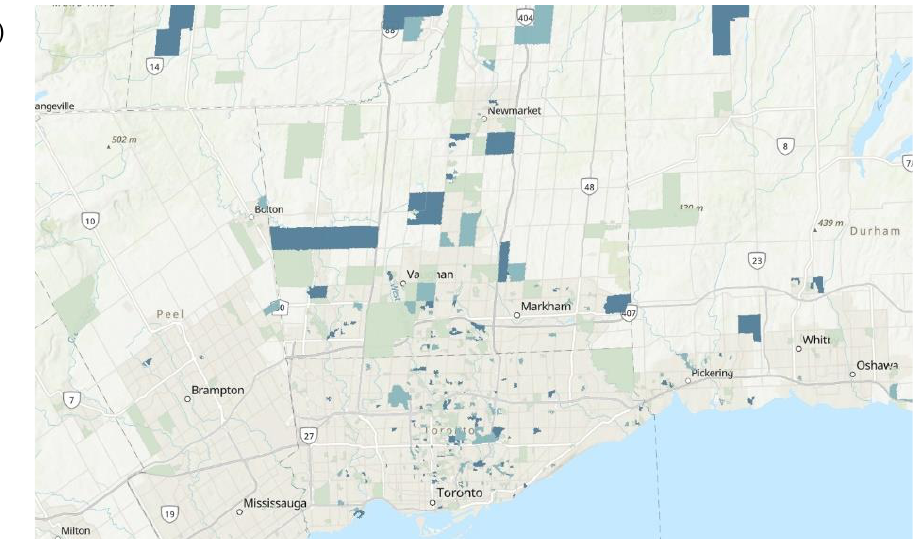
Figure 1. Average Delay Time of Examinations Between the pre-pandemic period (period 1) and during the height of the COVID – 19 pandemic period (period 2) of Examinations Per Dissemination Area. A map of Greater Toronto Area, Ontario, Canada with patients aggregated by dissemination area and average delay time (days) calculated for each dissemination was produced by ArcGIS online. Dissemination areas of patients are marked by a gradient based on delay time. The darkest blue shows a delay in examination >180 days while the lightest blue shows a delay in examination <90 days. Dissemination areas with no color have no patient data .